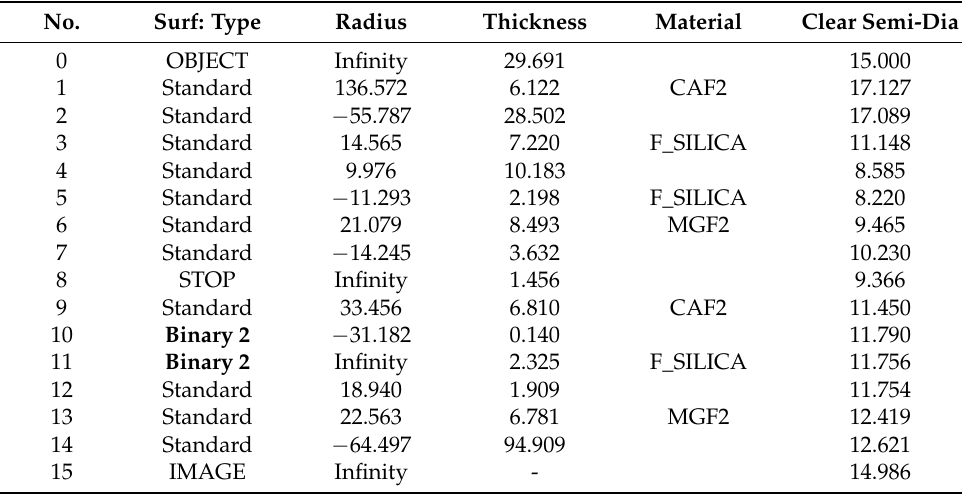
Table 3. Diffractive surface coefficient.